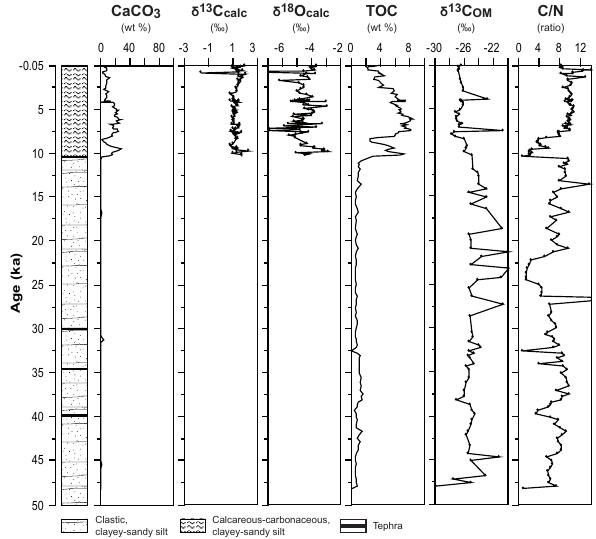
Fig. 3. Calcite and organic matter concentration and isotope data from Lake Prespa core